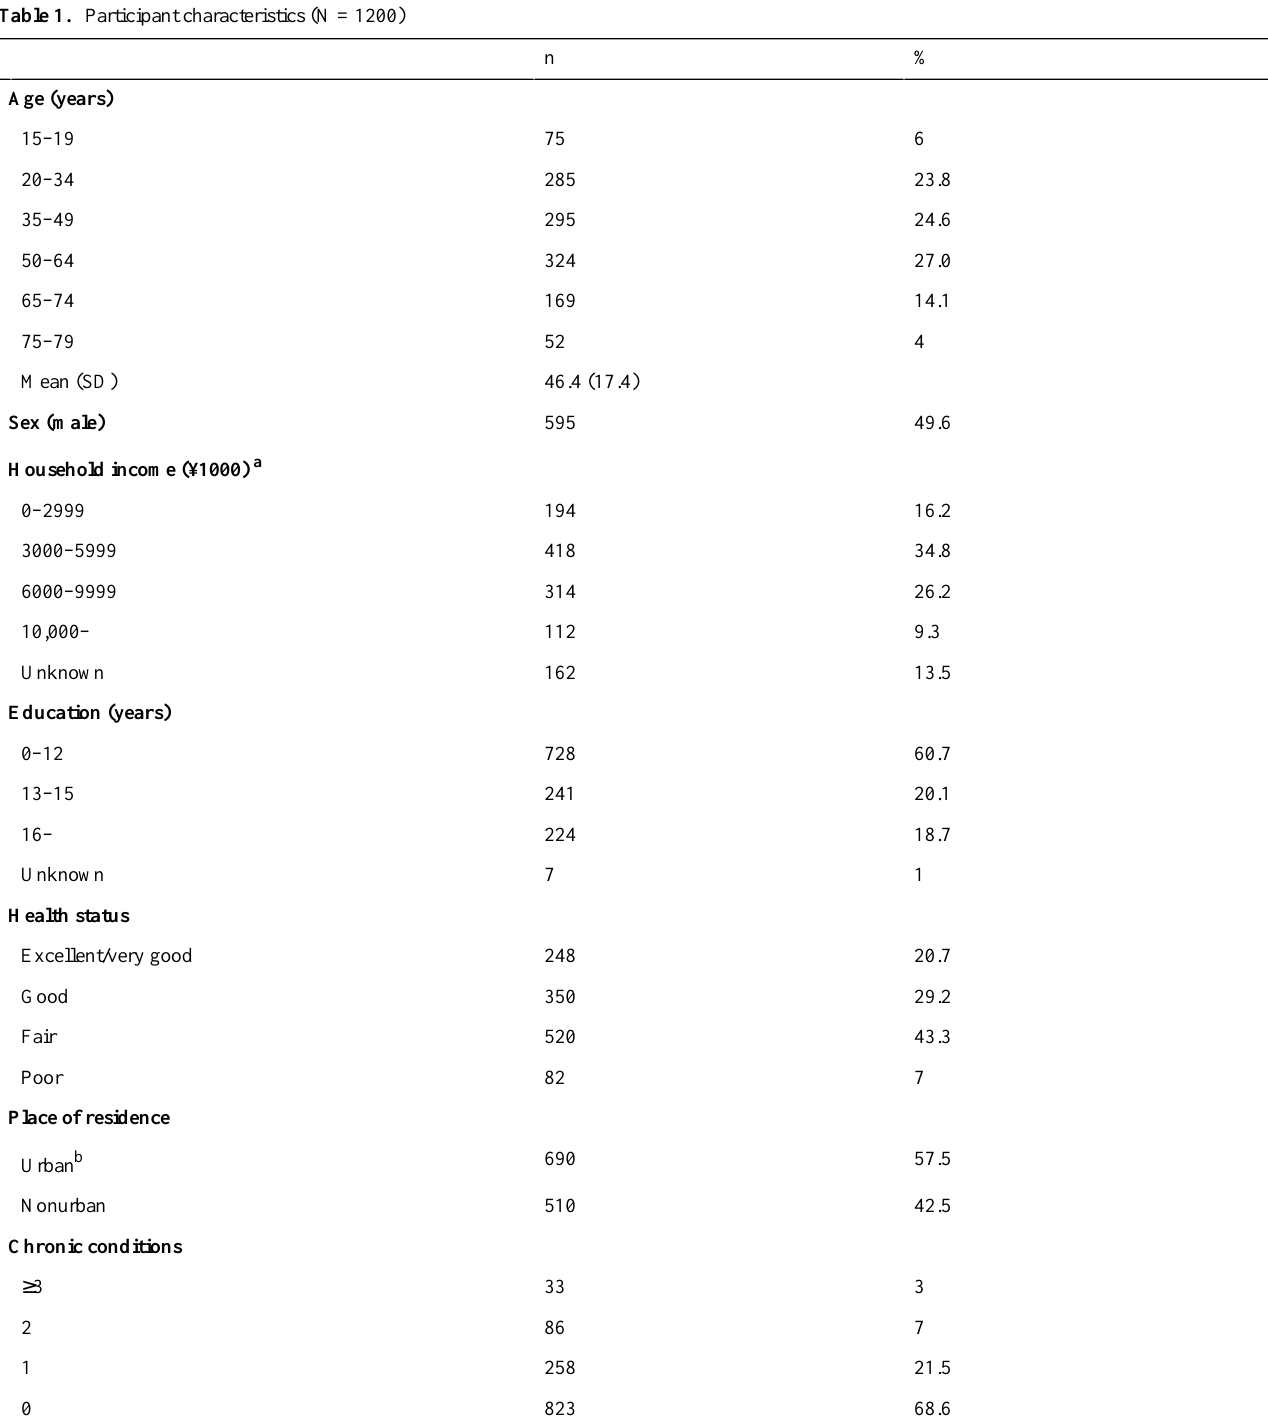
Table 1. Participant characteristics (N =